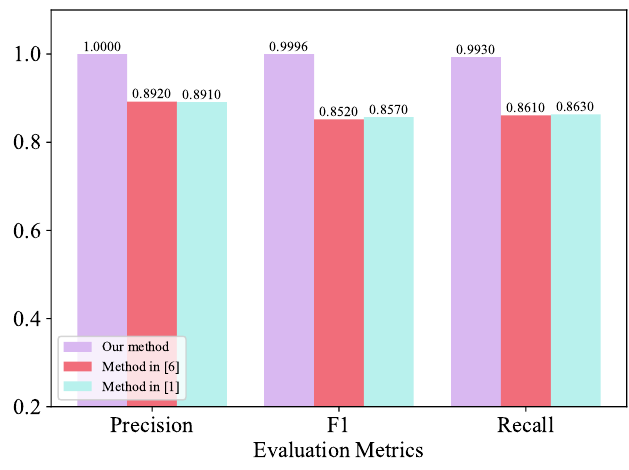
Figure 10. Performance comparison between our method and that of